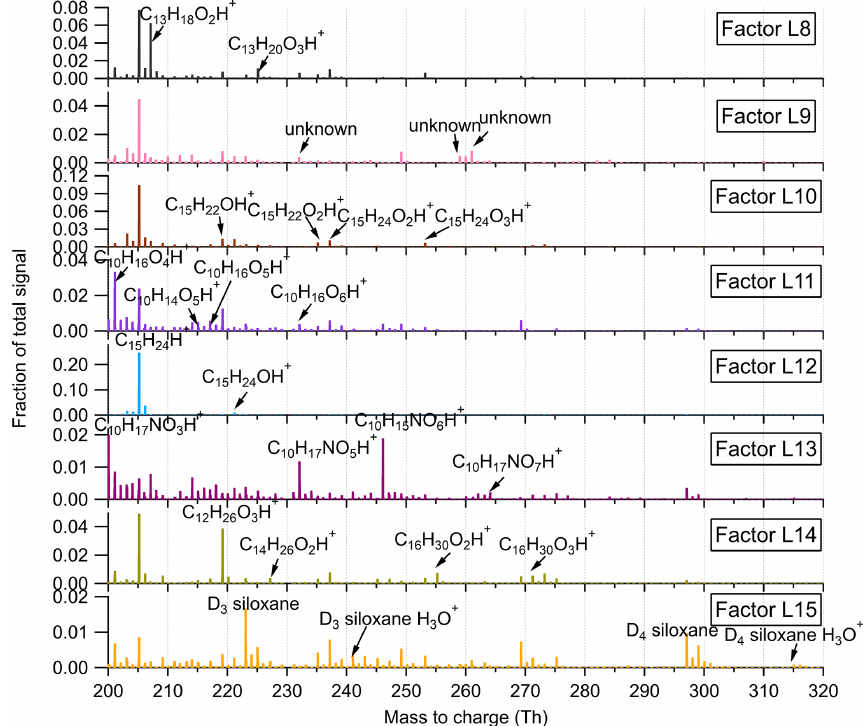
Figure 5. Mass profiles of the eight factors resolved in the high-mass range in the Landes forest, with major fingerprint peaks labeled in the mass spectra.